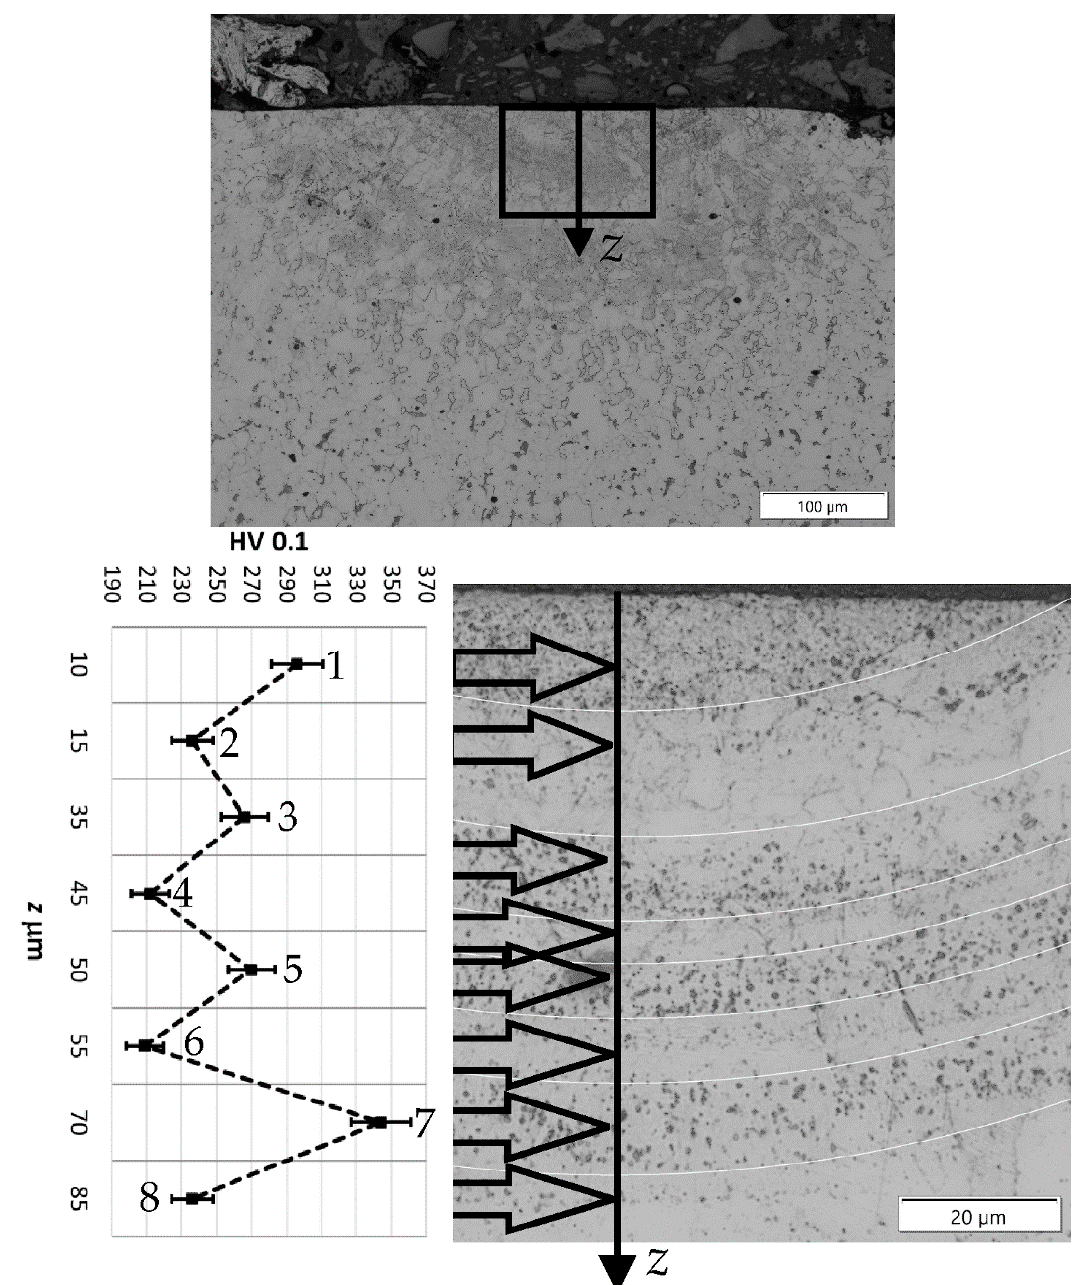
Figure 23. Sample no 3 reached with resonance frequency 1385 Hz acoustic vibration delivered par- allelly: ( a ) Metallography ( b ) SEM; PM—parent metal, HAZ—heat affected zone, TZ—transition zone, WM—weld metal.